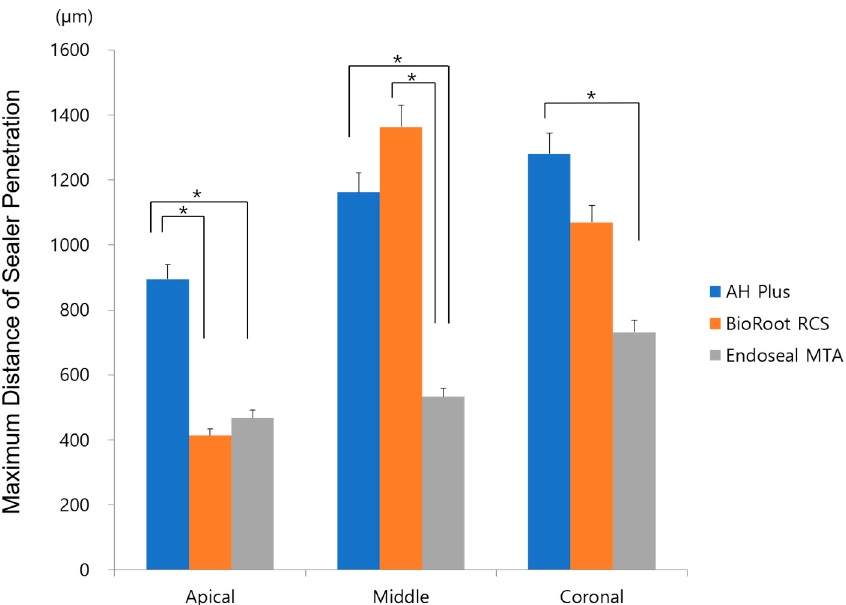
Figure 5. Maximum sealer penetration depth of all experimental sealers in the apical, middle, and coronal thirds. Stars indicate a statistically significant difference.